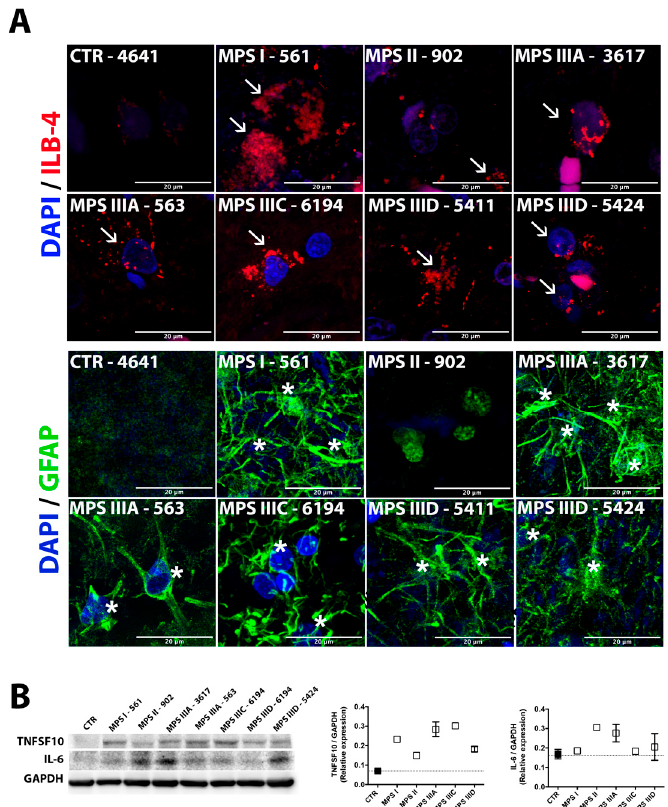
Figure 3. Astromicrogliosis in brain cortex tissues of human MPS patients is indicative of neuroinflammation. ( A ) Confocal microscopy images of brain cortex tissues of MPS I (561), MPS II (902), MPSIIIA (3617 and 563), MPS IIIC (6194), and MPS IIID (5411 and 5424) patients and a representative control (4641) stained with isolectin beta-4 (ILB-4,red) and antibodies against GFAP (green), markers for activated microglia and astrocytes, respectively. The fixed brain tissues of the MPS II patient HBCB1801OC were not sufficiently preserved to perform cryosectioning and conduct immunofluorescent analysis. DAPI (blue) was used as the nuclear counterstain. Activated microglia are marked with arrowheads and astrocytes are marked with asterisks; scale bar: 20 µ m. ( B ) Western blotting analysis showing increased protein expression of the proinflammatory cytokines (tumor necrosis factor superfamily member 10 (TNFSF10) and interleukin 6 (IL-6) in the brain cortex protein extracts from MPS patients and combined controls (662, 754, 1266, 4641, 5287, 5813, and 5977). Glyceraldehyde 3-phosphate dehydrogenase (GAPDH) was used as a loading control. Data are expressed as the mean ± s.e.m.